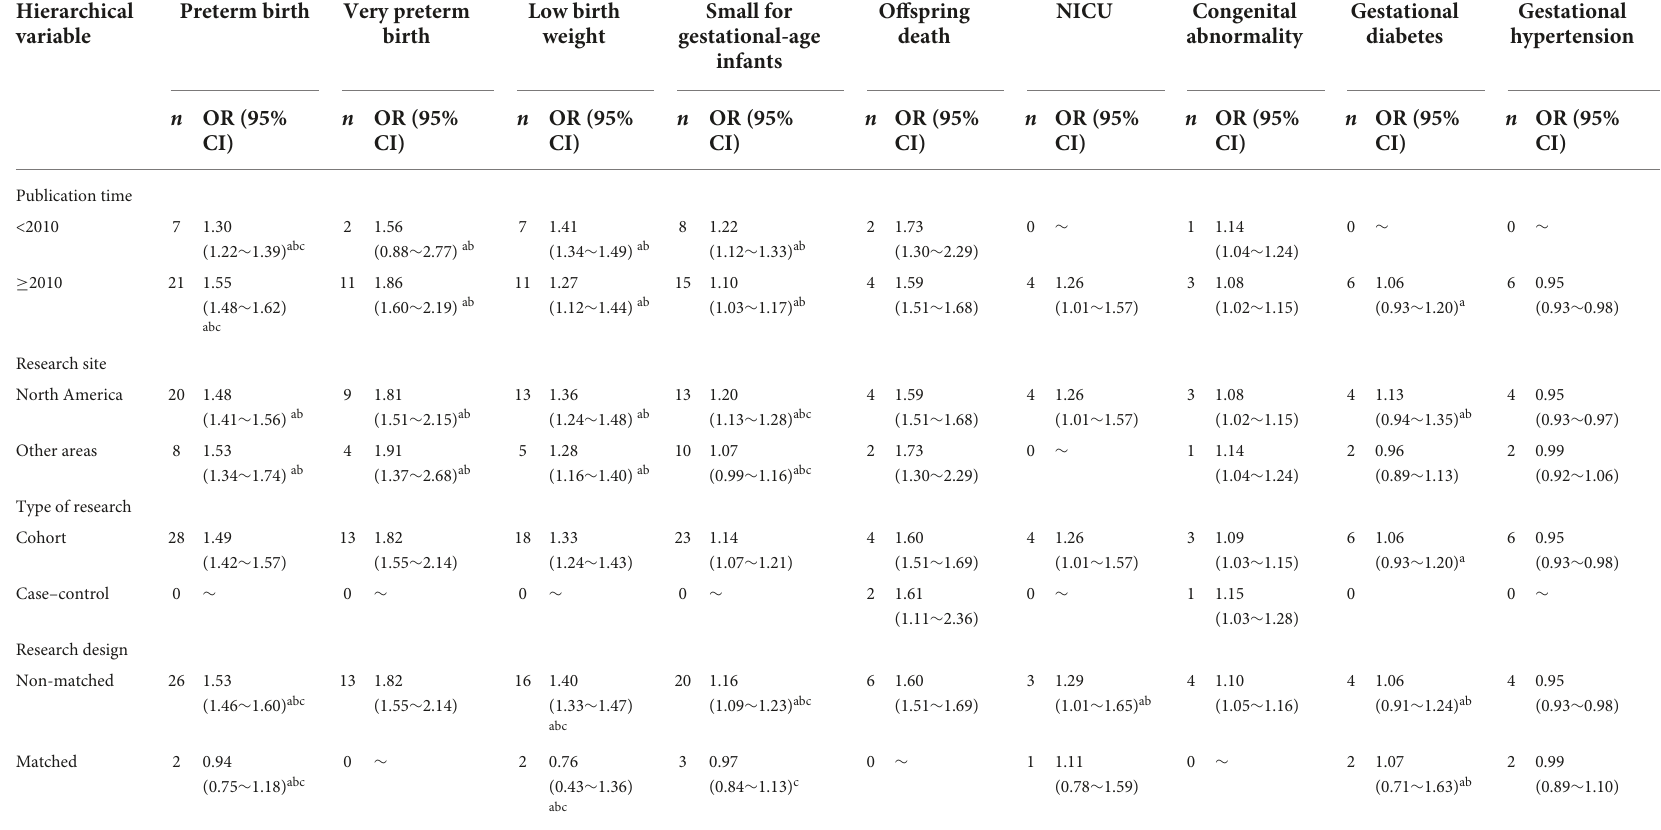
TABLE 2 Subgroup analysis of adverse pregnancy outcomes caused by short